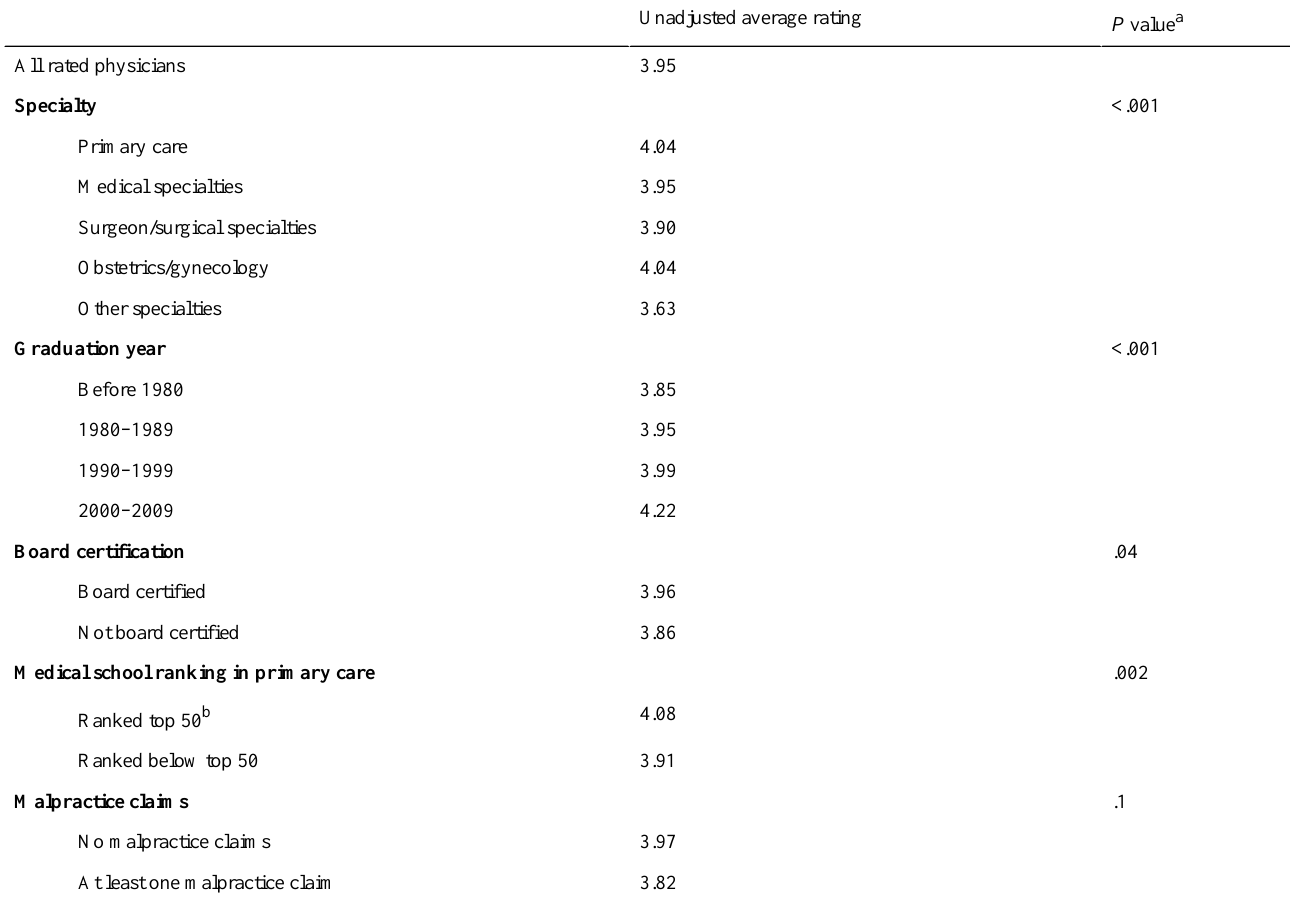
Table 3. Virginia physicians by the value of quality